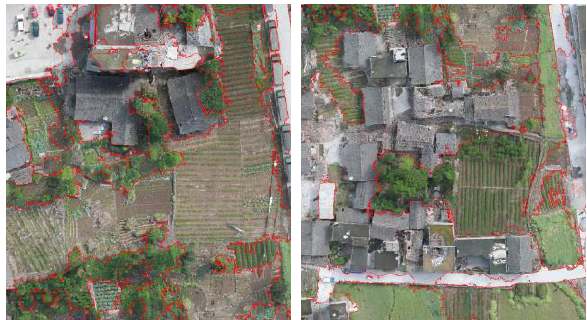
Figure 13. The distinguished area of grassy land and buildings in the optimal segmentation